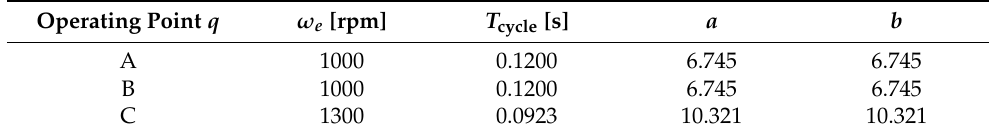
Table 5. Nominal plant model ˜ g q ,11,nom